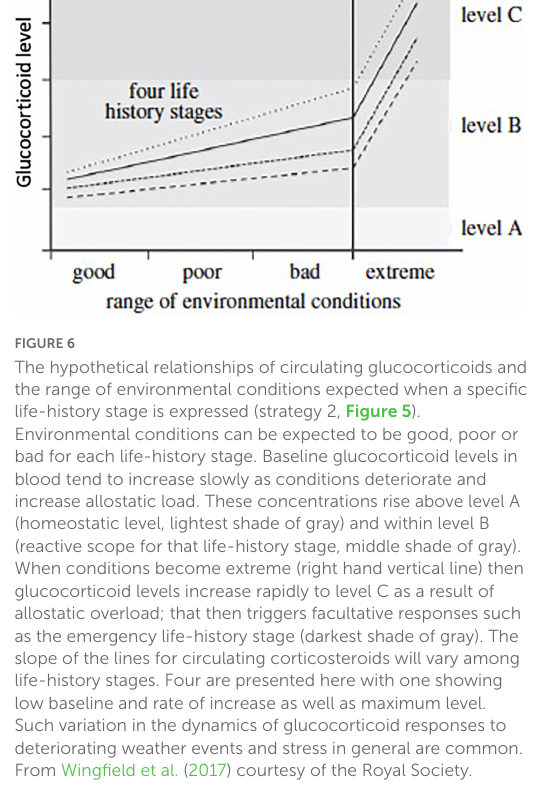
but instead initiates flight at the point where the risk of remaining outweighs the cost of surrendering their